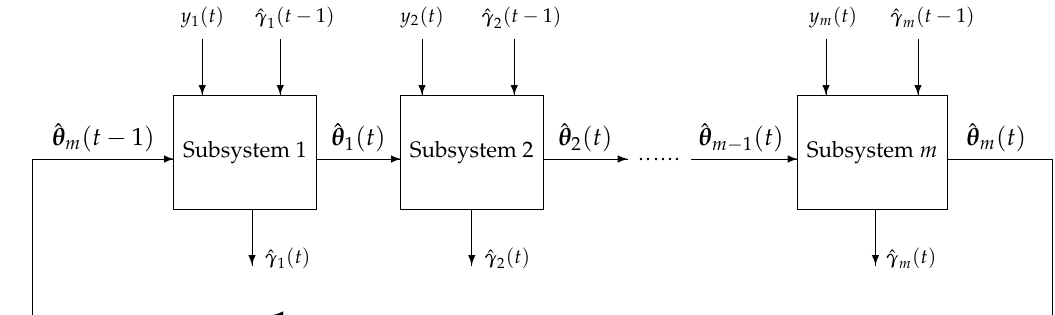
Figure 1. The schematic diagram of the M-PC-GSG